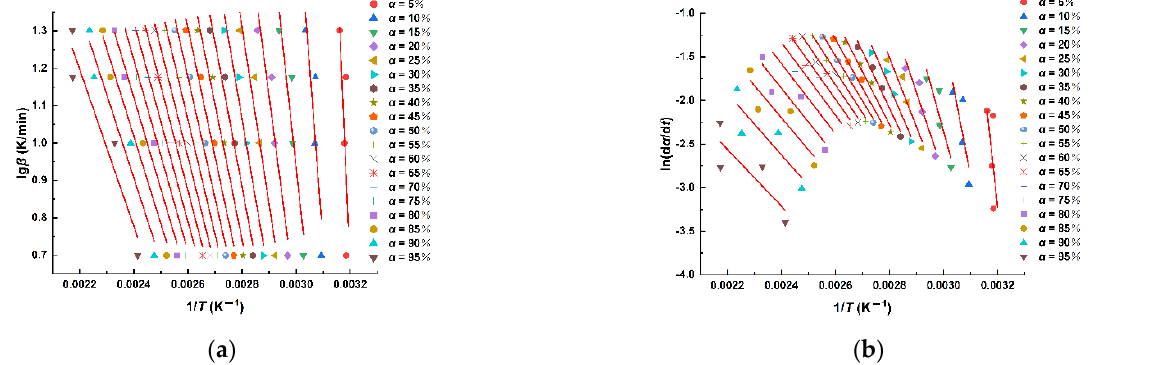
Figure 5. ( a ) The Flynn – Wall – Ozawa analysis of MDI-based polyurethane; ( b ) The Friedman analysis of MDI-based polyurethane.